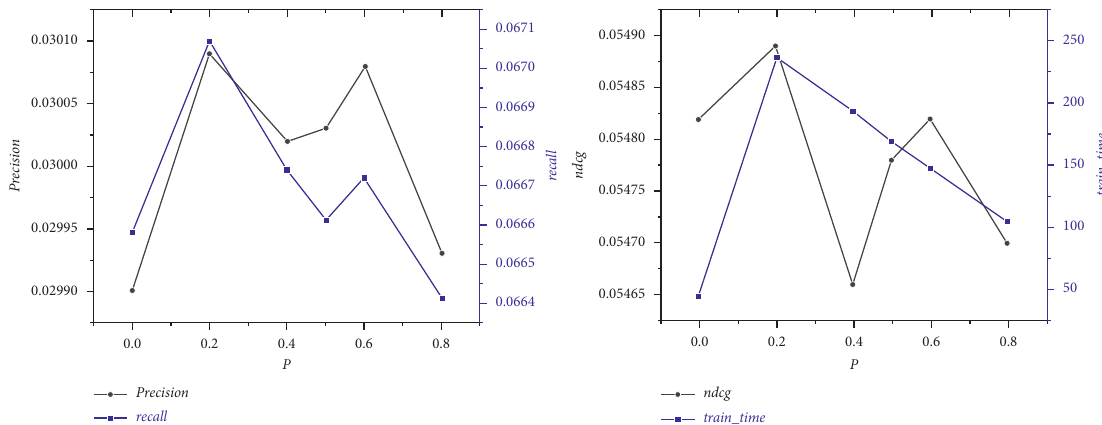
Figure 6: Algorithm performance under different edge drop rates (Yelp2018).